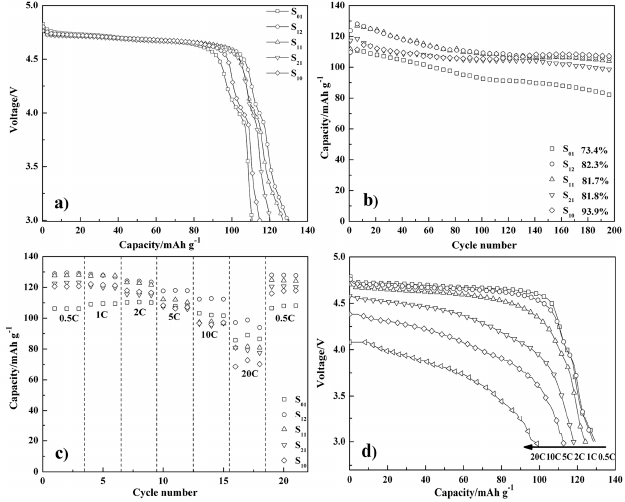
Figure 7. ( a ) The galvanostatic discharge curves (highest discharge capacity) of the LNMO samples prepared by mixed precipitants of (NH 4 ) 2 CO 3 and Na 2 CO 3 with different molar ratios; ( b ) the cycle performances of the LNMO samples at 0.5 C; ( c ) the rate performances of the LNMO samples at various C-rates; ( d ) the discharge curves of S 12 at different C-rates.